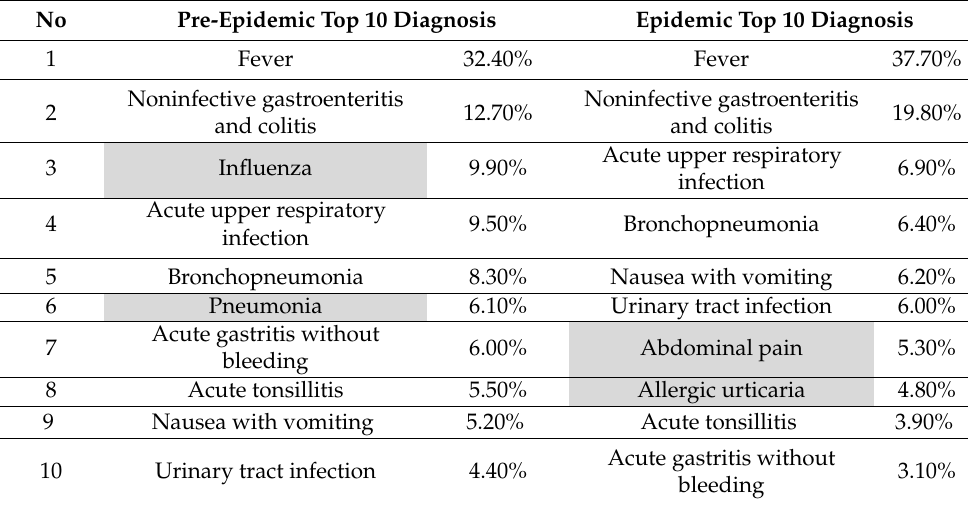
The gray background color indicates the change in the top 10